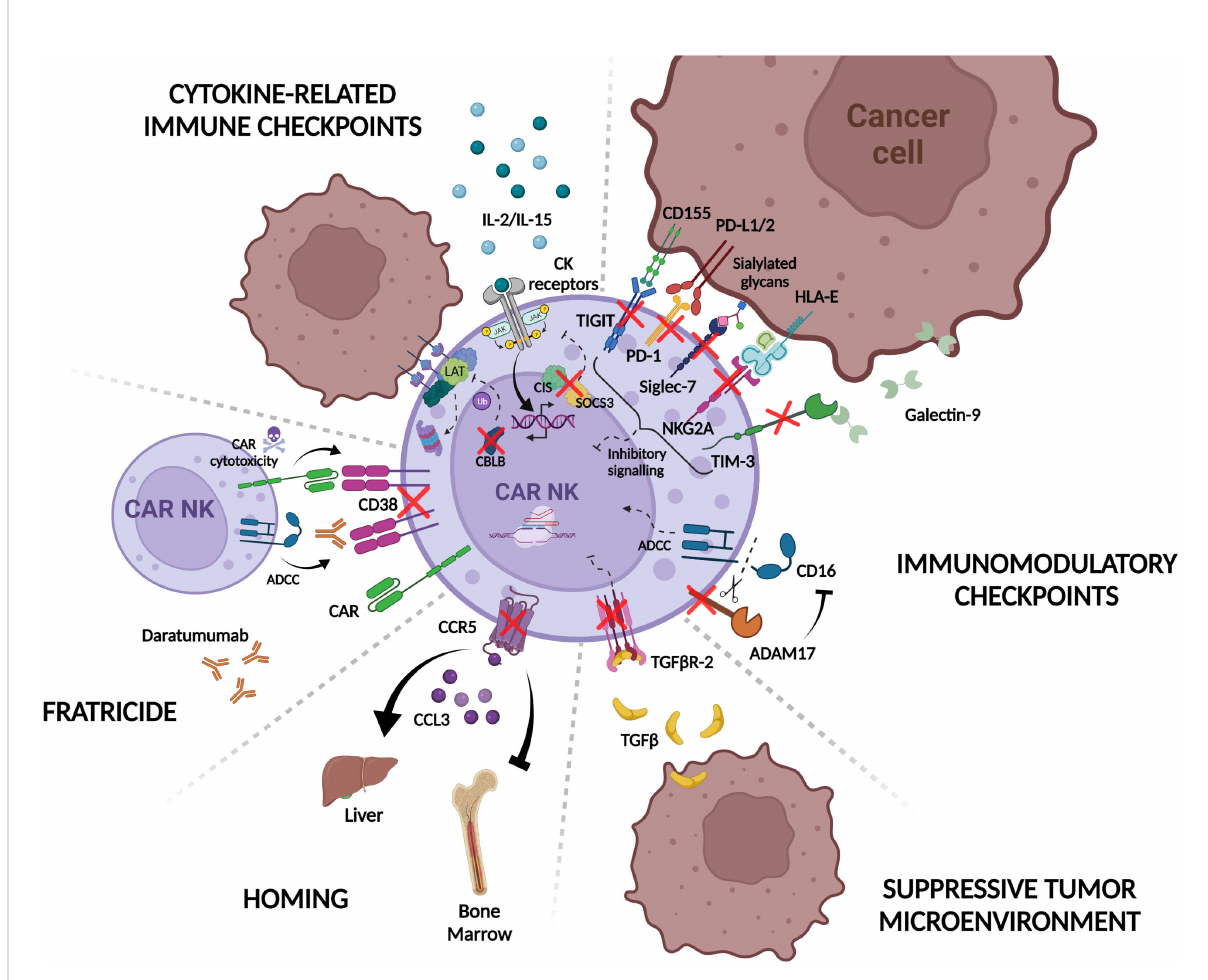
FIGURE 4 CRISPR/Cas9 knock-out strategies to improve CAR-NK immunotherapy. CAR-NK function and cytotoxicity are modulated by intrinsic mechanisms in NK cells. For example, engagement of tumor ligands with NK immunomodulatory checkpoint receptors such as TIGIT, PD-1, NKG2A, TIM-3, and Siglec-7, inhibit CAR-NK cell response to target cells. ADAM17 also restrains NK cell ADCC response by shedding CD16 receptor from the NK cell surface. Additionally, in response to cytokine signaling, the expression of internal checkpoints including CLBL, SOCS3, and CIS regulate NK activation and immune synapsis formation with tumor cells. The suppressive tumor microenvironment contributes as well to CAR-NK inhibition through the release of suppressive factors like TGF- b . In this context, CAR-NK potency is attenuated and less effective against tumor cells. CAR-NK cell homing is also regulated by chemokine receptors such as CCR5 that mediates homing to the liver in response to CCL3 reducing CAR-NK ef fi cacy against bone marrow-resident tumors. Another problem that CAR-NK manufacturing can encounter is fratricide either by expression of the CAR-targeted molecule on the surface of the effector cell or the use of monoclonal antibodies that bind to NK cells and induce “ self-killing ” through ADCC. Ablation of different NK cell proteins implicated in these pathways by the use of the CRISPR/ Cas9 system (red crosses) would overcome the aforementioned limitations and result in more potent, persistent, and tumor-directed CAR-NK effectors for their use in adoptive immunotherapy. PD-1, Programmed Death 1; TIGIT, T cell immunoglobulin and ITIM domain; TIM-3, T cell immunoglobulin and mucin-domain containing-3; NKG2A, natural killer group 2A; PD-L1/2, Programmed Death ligand-1/2; HLA-E, HLA class I histocompatibility antigen, alpha chain E; ADAM-17, A disintegrin and metalloprotease 17; TGF- b , Transforming growth factor beta; TGF b R-2, Transforming growth factor beta receptor type 2; CCL3 Chemokine (C-C motif) ligand 3; CCR5, C-C chemokine receptor type 5; CAR, chimeric antigen receptor; ADCC, Antibody-dependent cellular cytotoxicity; CK, cytokines; CIS, cytokine-inducible SH2-containing protein; SOCS3, suppressors of cytokine signaling; LAT, linker for activation of T cell; CBLB, Casitas B-lineage lymphoma protooncogene B Created with